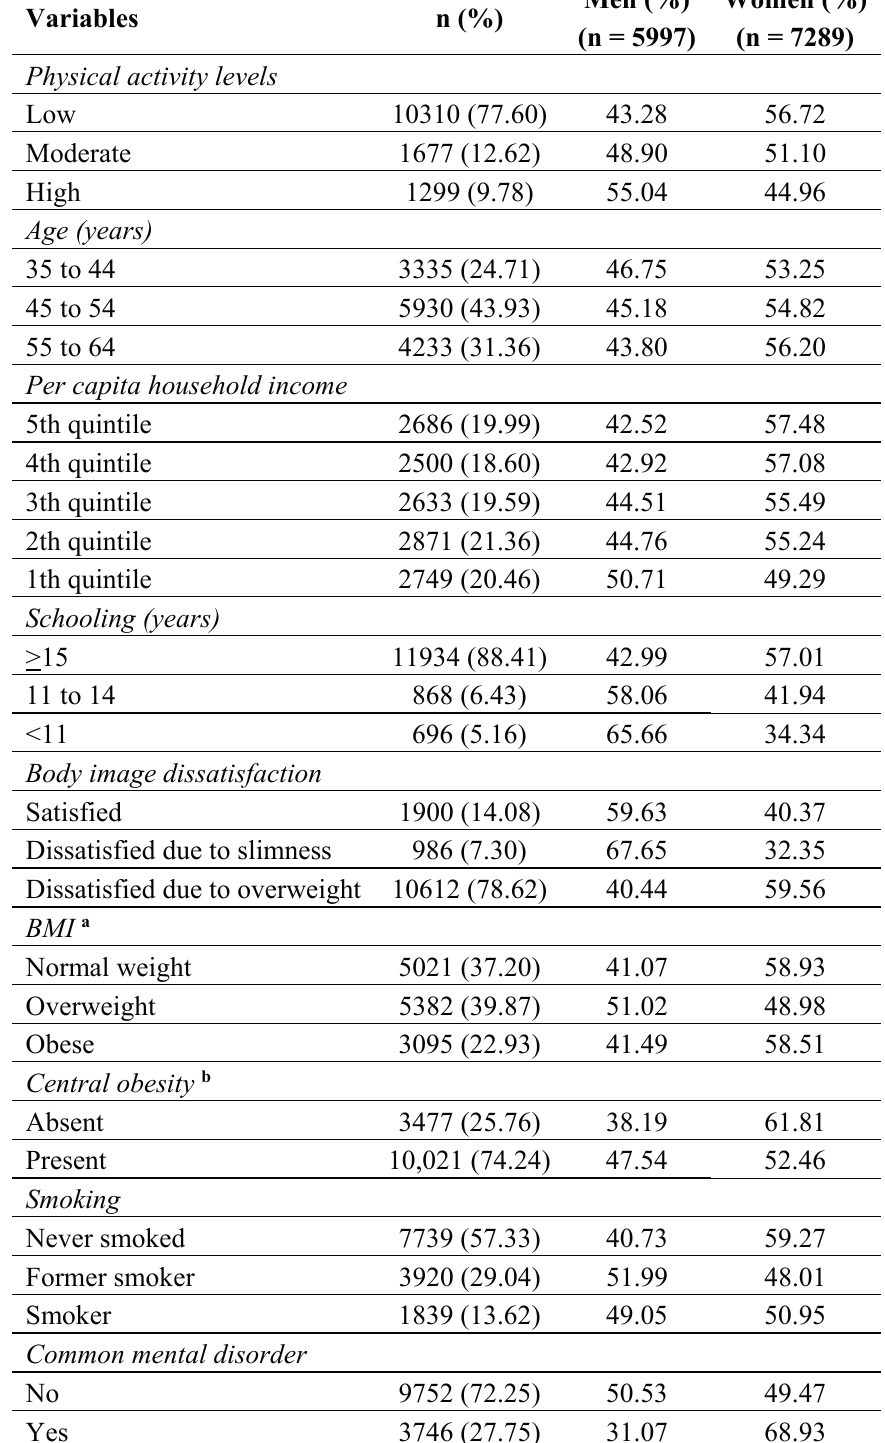
Table 1. Distribution of the general characteristics of the participants (35–64 years-old), according to sex. ELSA-Brasil